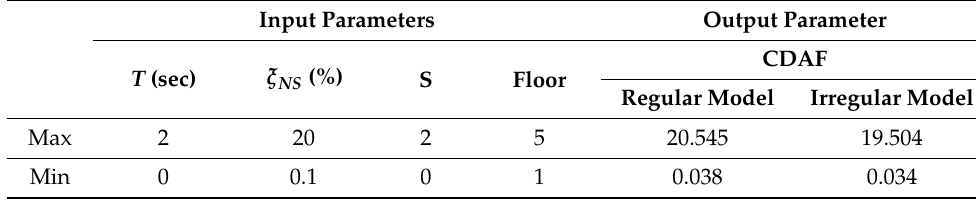
Table 9. Limits of input and output parameters.